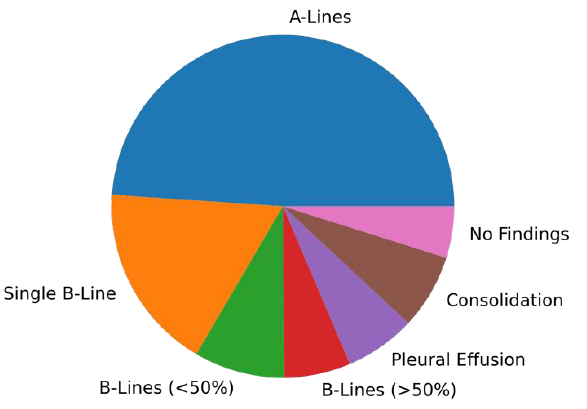
Figure 7. Pie chart with the distribution of findings observed by the participants in all the videos considered. A reduced number of severe cases can be observed.